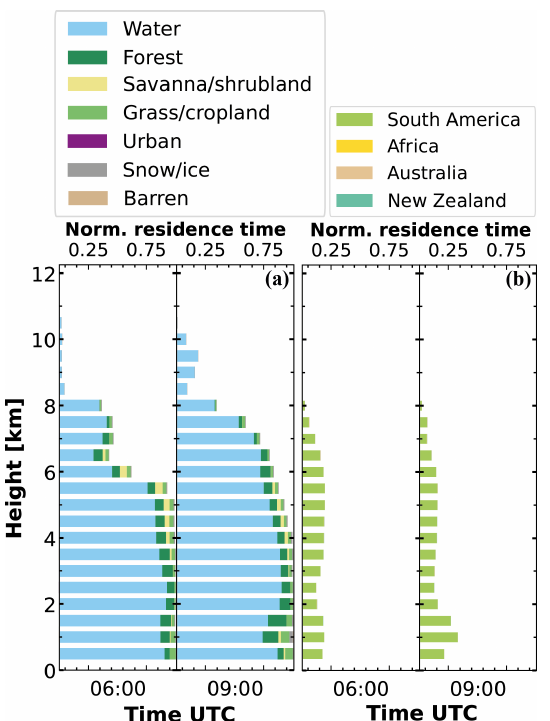
Figure 4. Normalized residence time as a function of height (km), and time (UTC) at which the air masses arrived at several heights over Punta Arenas on 5 February 2019. ( a ) Type of surface and ( b ) geographical regions. Residence time is calculated using a reception height of 8 km.